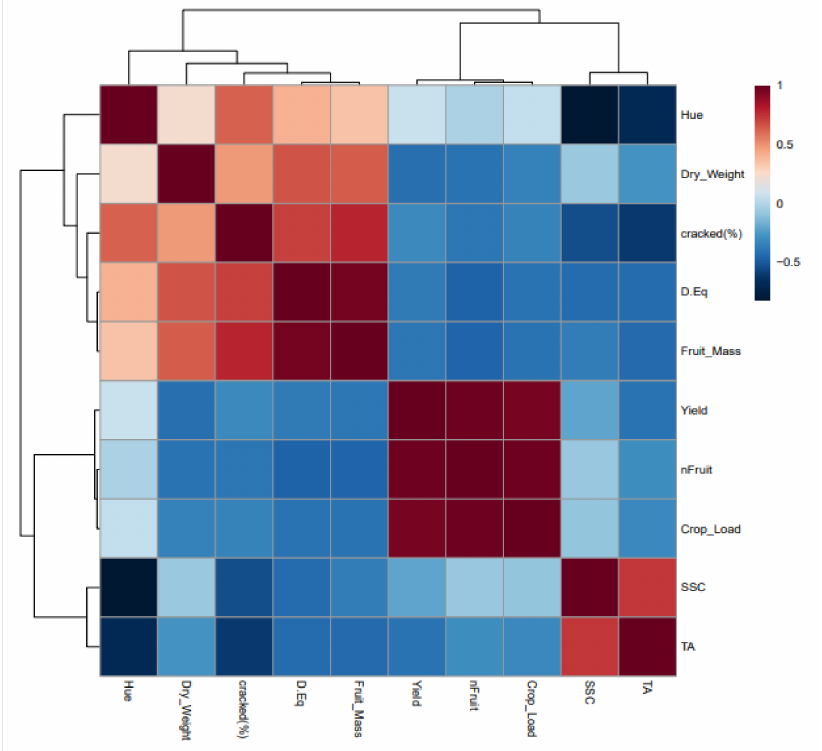
Figure 6. Correlation heat map of the quality parameters